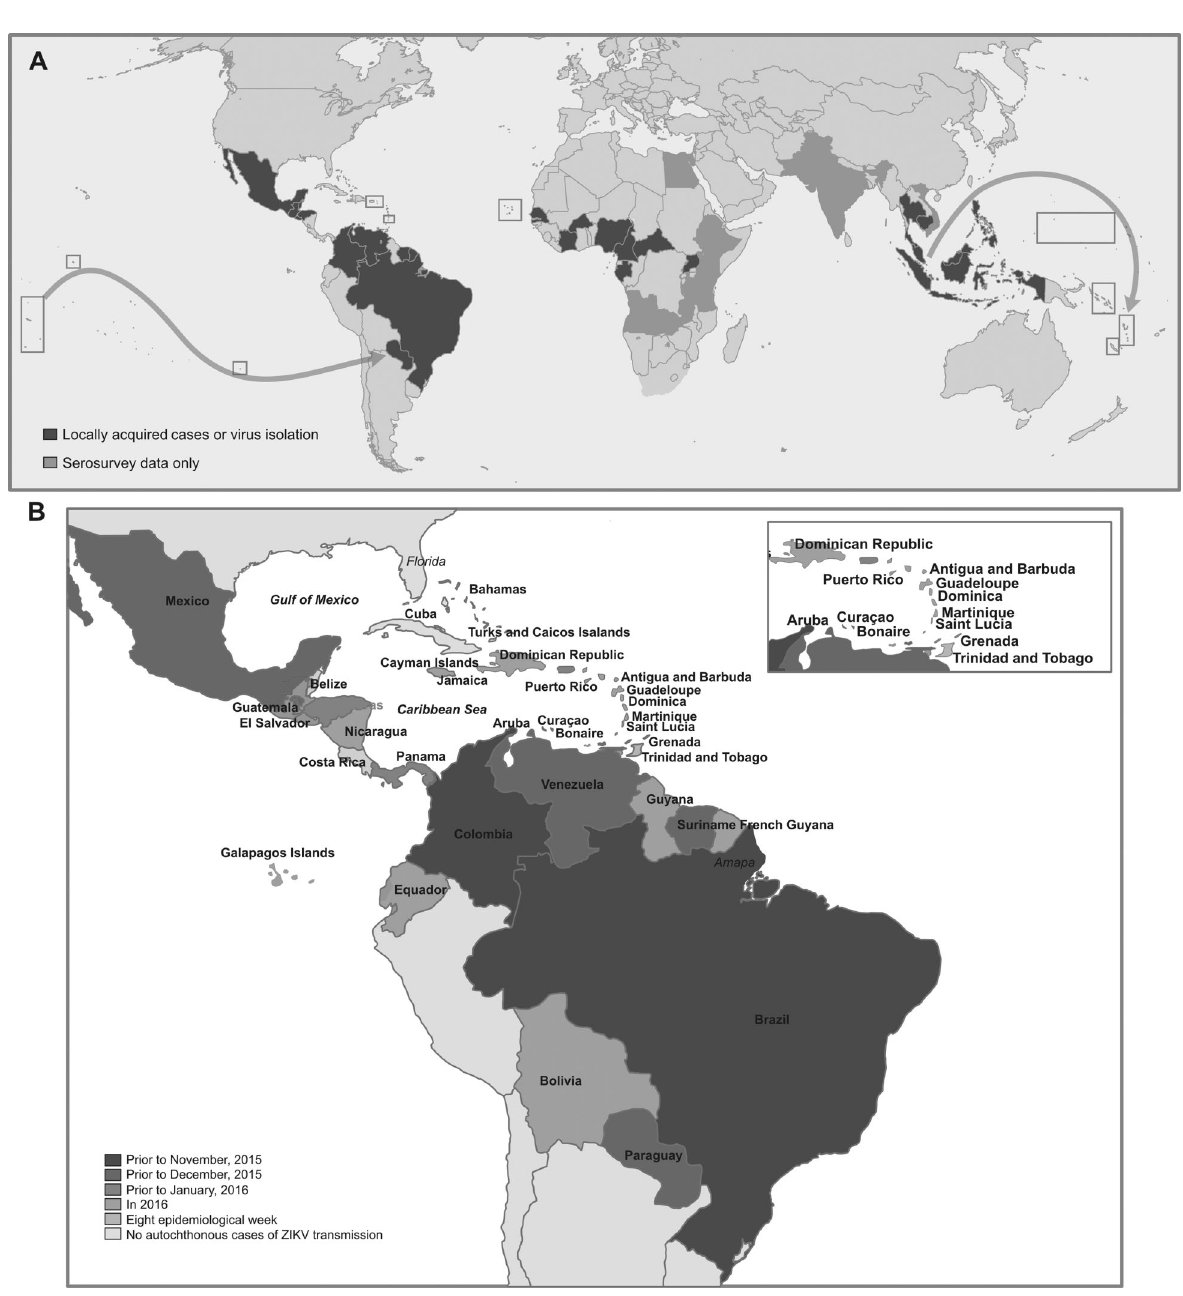
Figure 1. World epidemiology of ZIKV infection. A , Global expansion of the Asian lineage. After the characterization and isolation of ZIKV in Uganda, until 2007 only few human cases were reported in some African and Southeast Asiatic countries. The fi rst signi fi cant ZIKV outbreak was registered in Yap Island, Micronesia, geographically situated close to Indonesia, where ZIKV is endemic (arrow). Between 2013 and 2014, ZIKV was rapidly spread to many of the islands of the Southern Paci fi c Ocean, causing the largest outbreak in French Polynesia. In 2015, the fi rst autochthonous cases were detected in Brazil. B , Epidemiology of ZIKV infection in Central and South America. Currently, Brazil is the most affected country in South America followed by Colombia (maps adapted from the Pan-American World Health Organization, PAHO, Zika-epidemiological